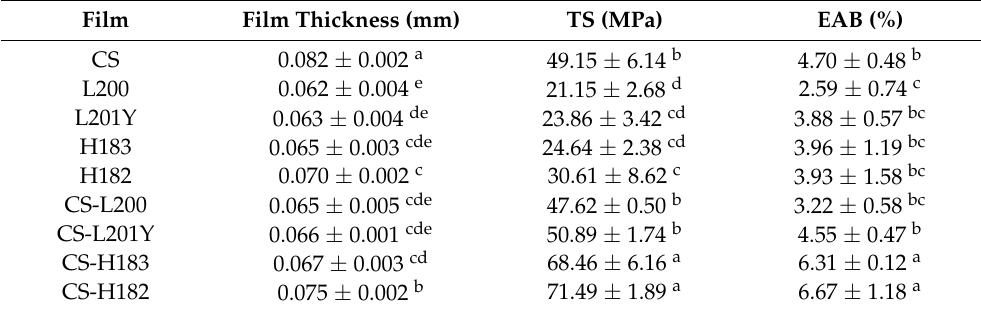
Table 4. Thickness and mechanical properties of different monolayer and bilayer